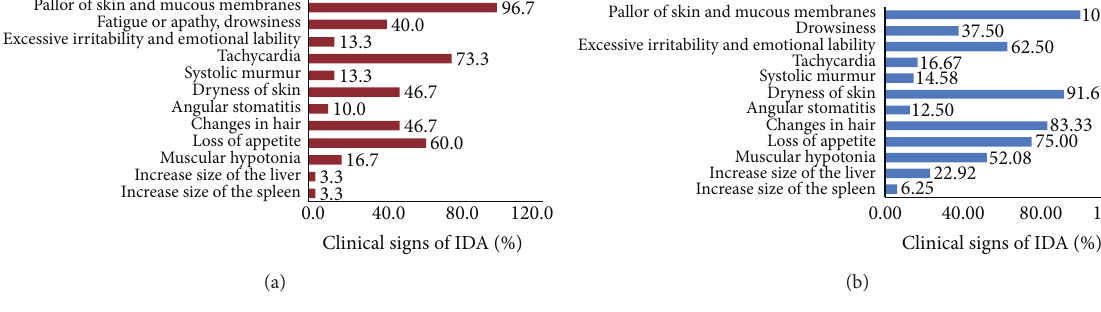
Figure 1: Clinical signs of IDA in I group (a) and II group (b).